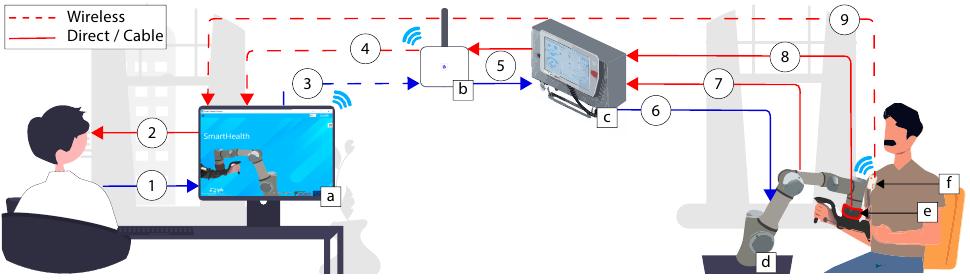
Figure 1. Illustration of the overall system